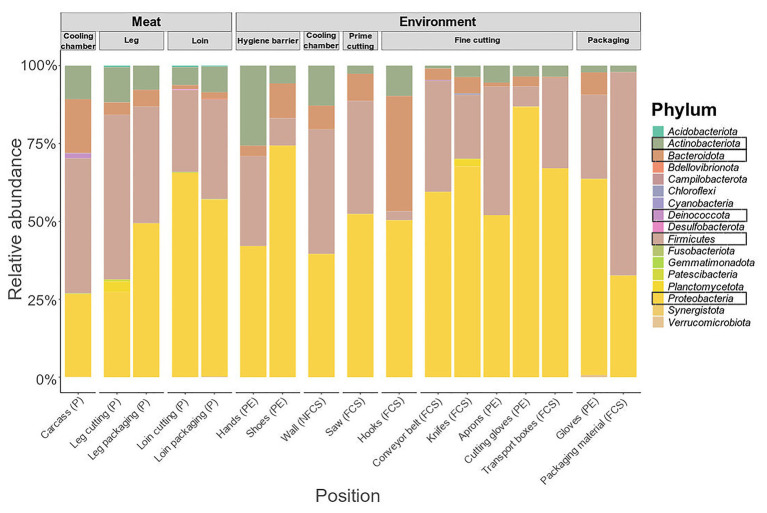
Phylum-level classification of 16S rRNA gene sequence reads parted by sampling position and type (meat or environment). Data represent average of amplicon sequence variant (ASV) counts from replicate libraries for each category. Sample categories are abbreviated: “product” (P), “food contact surface” (FCS), “non-FCS” (NFCS), and “personnel” (PE).